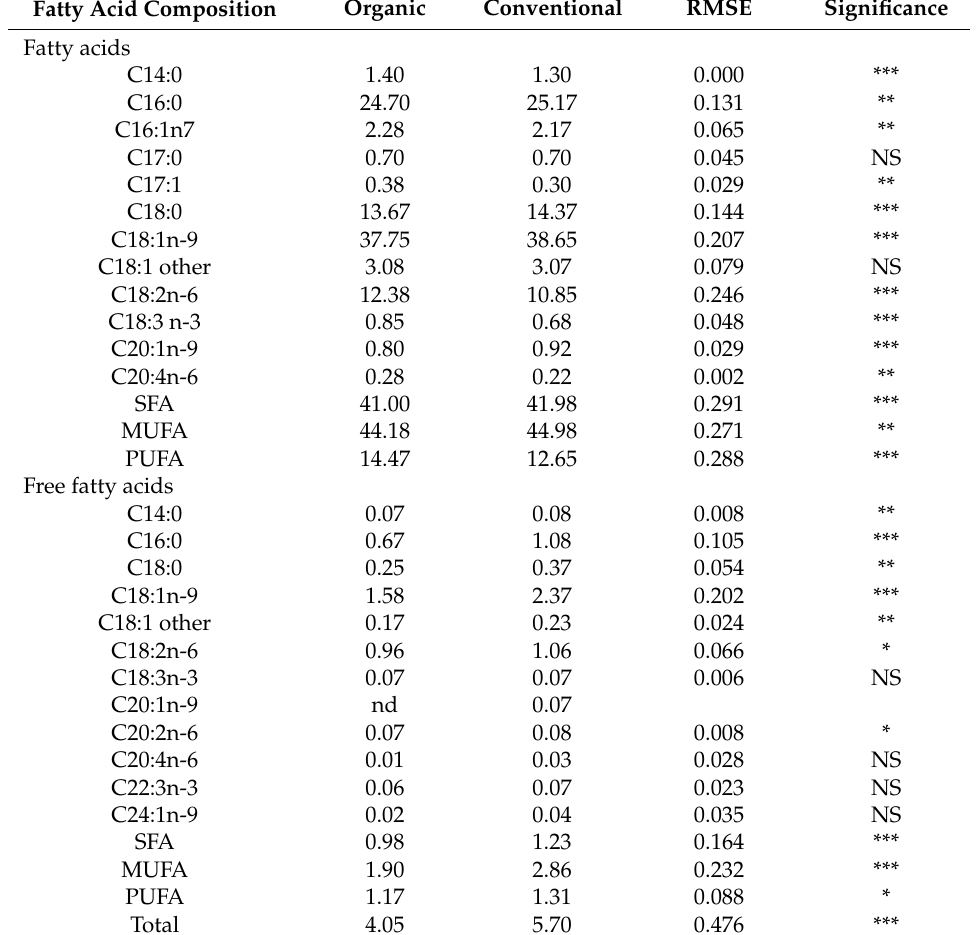
Table 2. Fatty acid and free fatty acid composition (g/100 g fat) of dry-fermented sausages (six per treatment group) manufactured without nitrite addition from organic and conventional